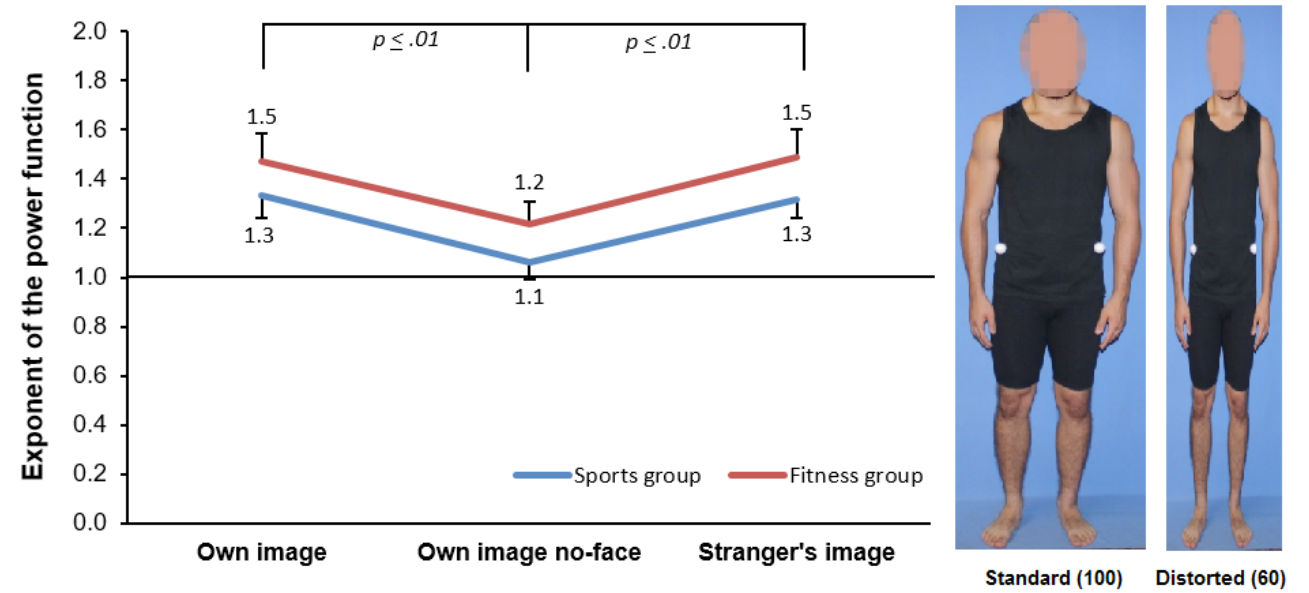
Figure 7. Geometric mean of the power function’s exponents of two groups of male participants (sports and fitness) for magnitude estimation of own body image and strangers’, and own body image without face (Tavares,